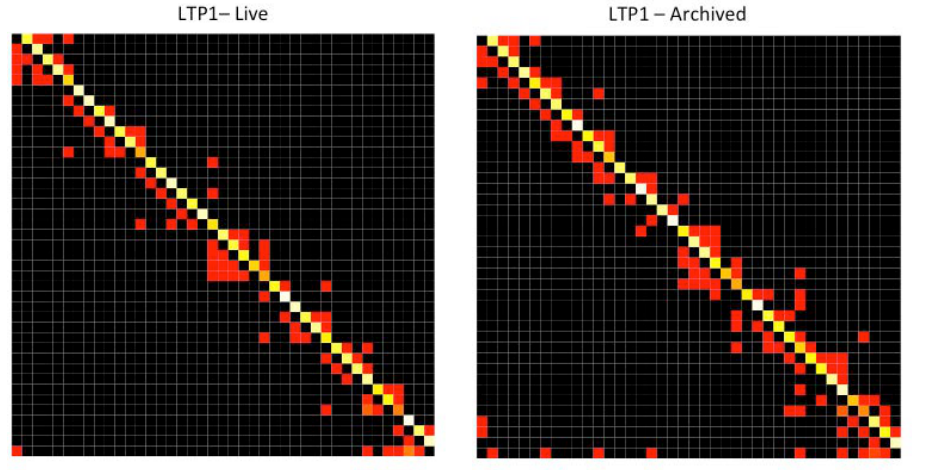
Figure 5 . Video transition matrices for LTP1, intent category all